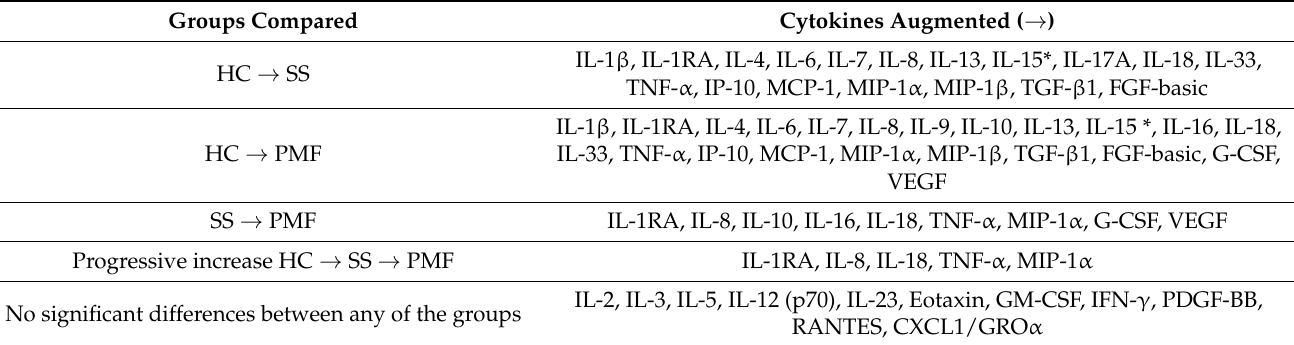
Table 2. Summary of cytokine levels